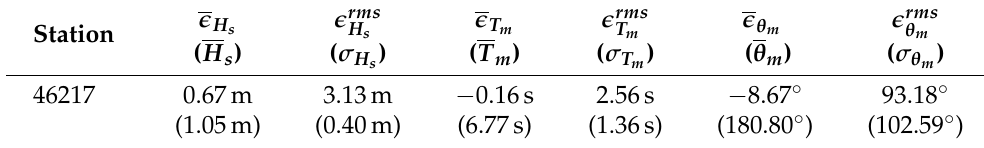
Table 1. Error statistics for significant wave height ( H s ), mean wave period ( T m ) and mean wave direction ( θ m ) from comparison of the SWAN assimilation results to observation data used in the background. The mean error in quantity X is (cid:101) X , the RMS error is (cid:101) rms . For comparison, the mean and X standard deviation of the observations ( X and σ X ) are included on the second line, in parentheses.